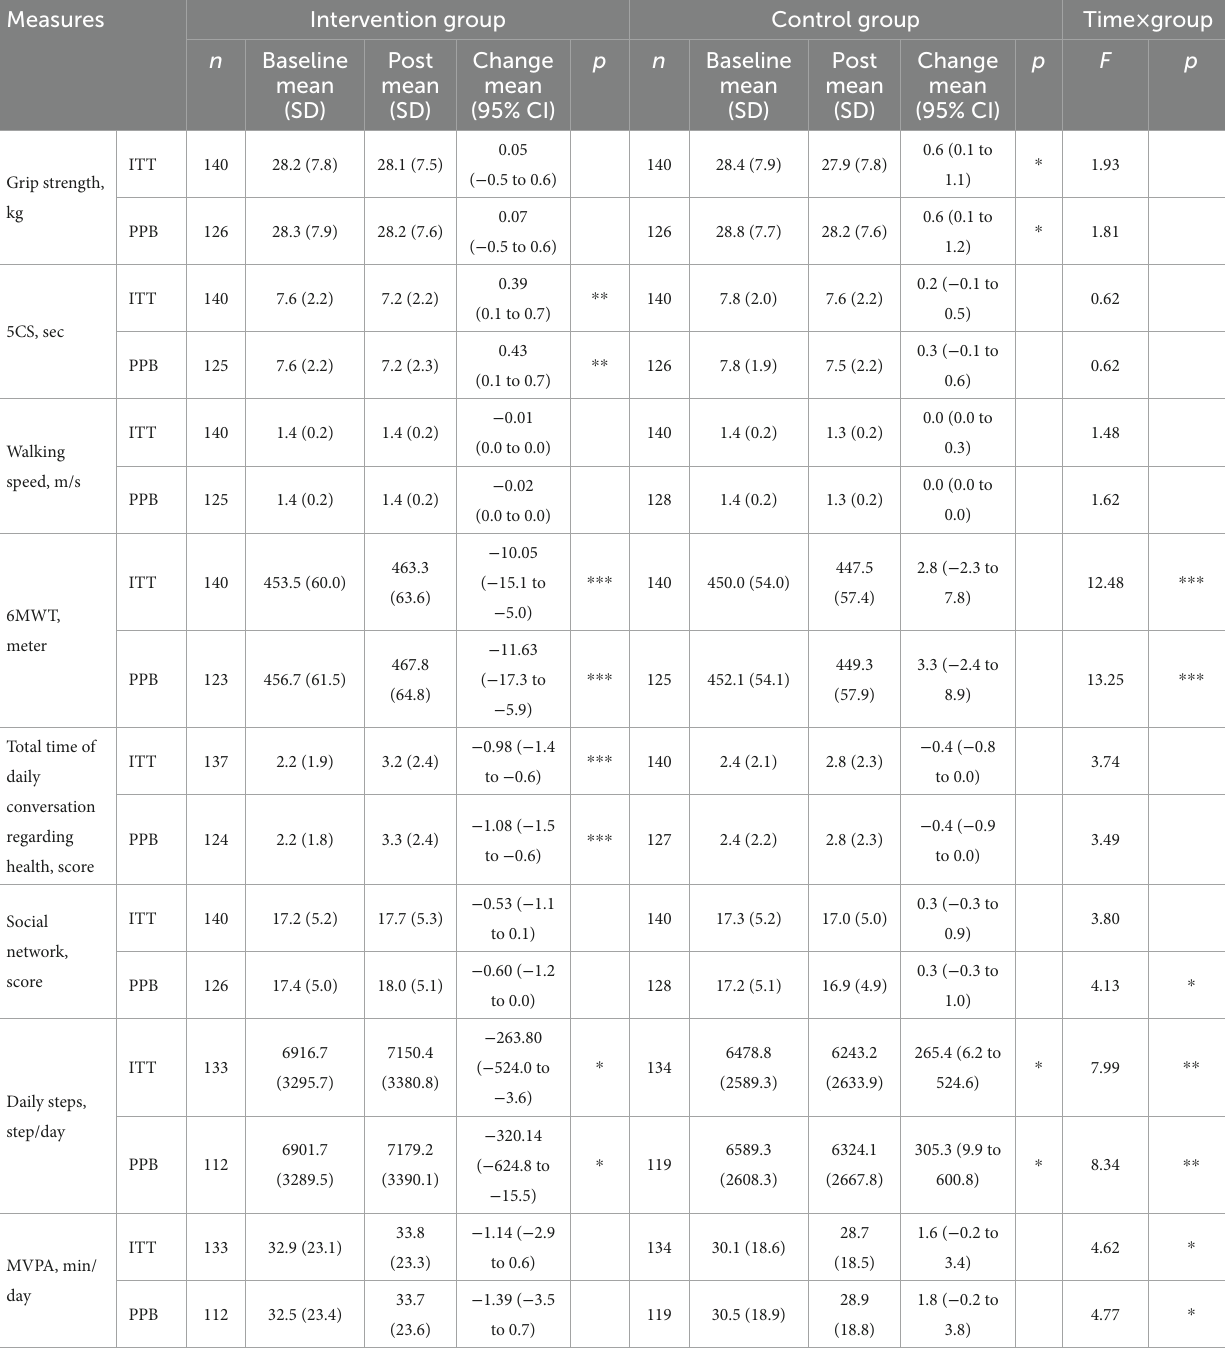
TABLE 3 Effects of the intervention and time on the secondary outcomes among older adults (intention-to-treat method and per protocol based).